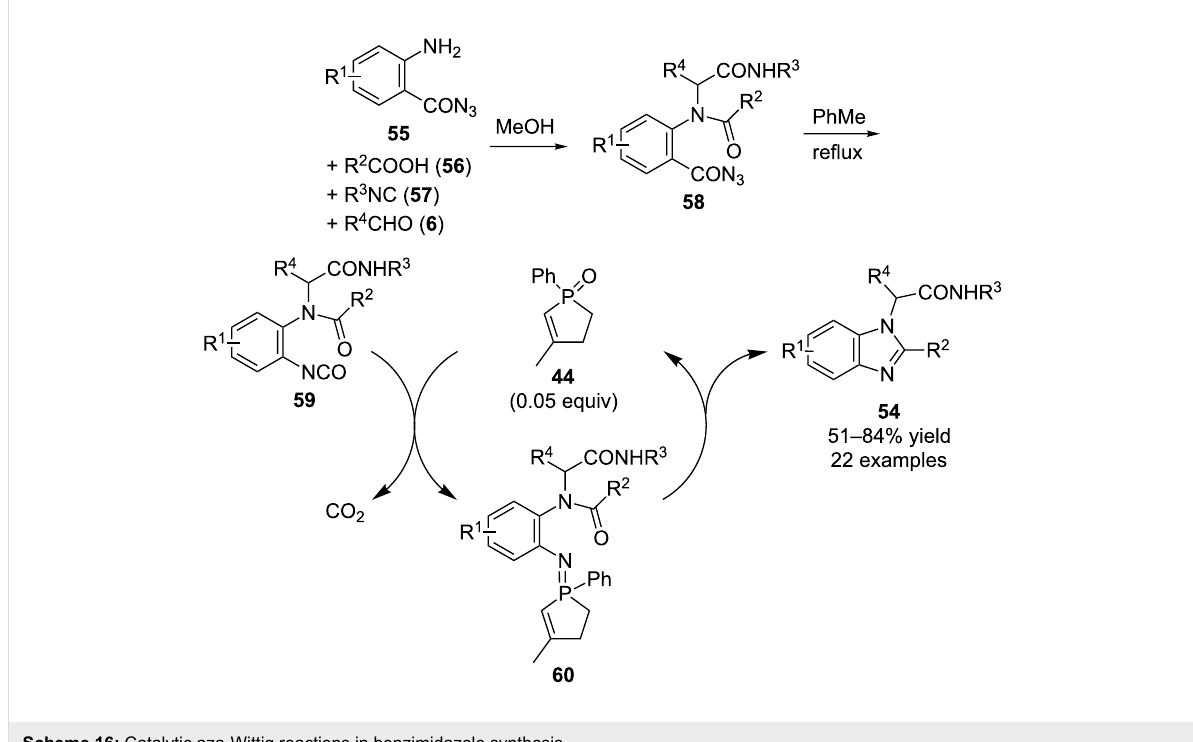
aza-Wittig reactions with 44 produced cyclized final products 54 via iminophosphoranes 60